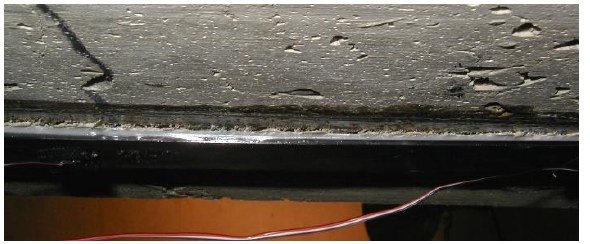
Figure 1. Intermediate crack (IC) [10].